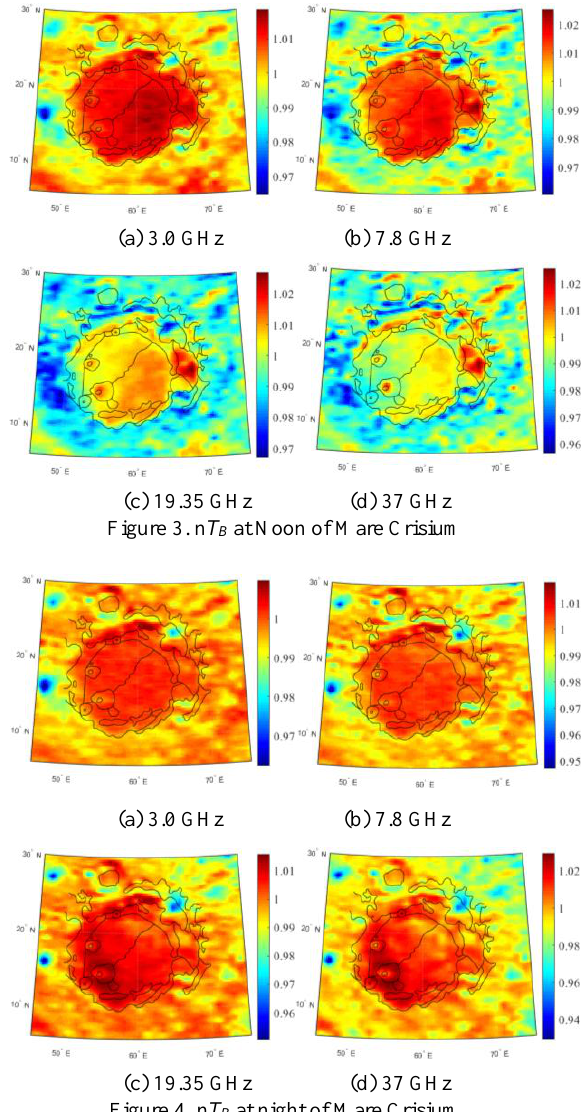
Figure 4. n T B at night of Mare